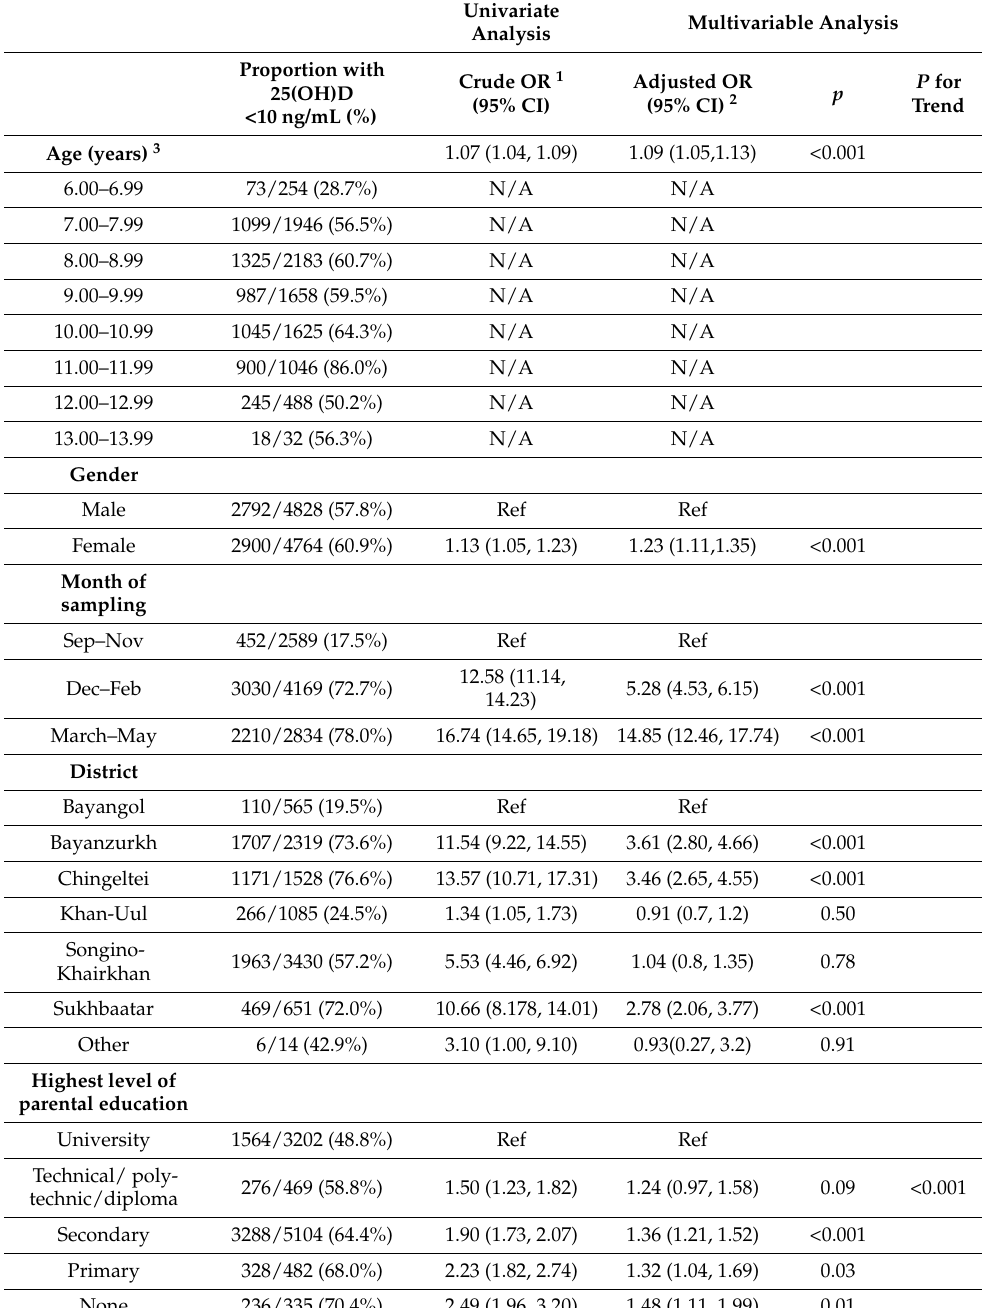
Table 2. Determinants of vitamin D status.